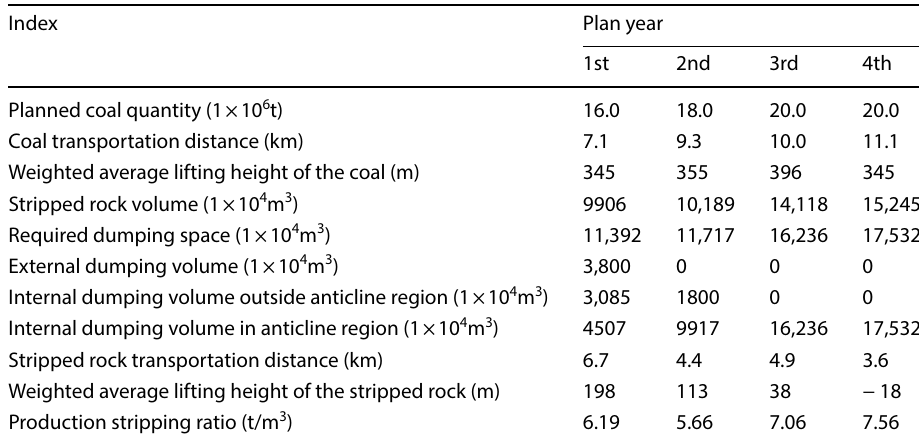
Table 6 Technical index summary of mining and dumping plan of northern priority development